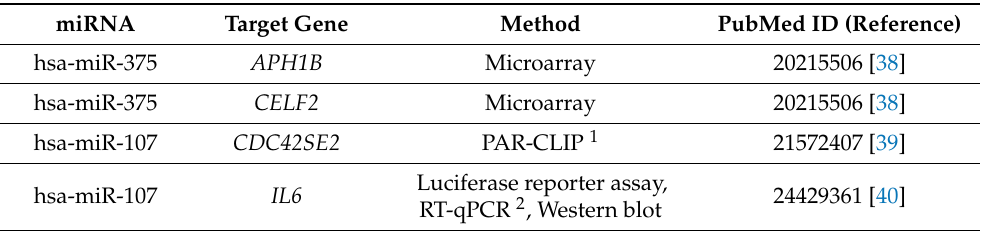
Table 1. Common experimentally confirmed MTI identified by both literature screening and database mining